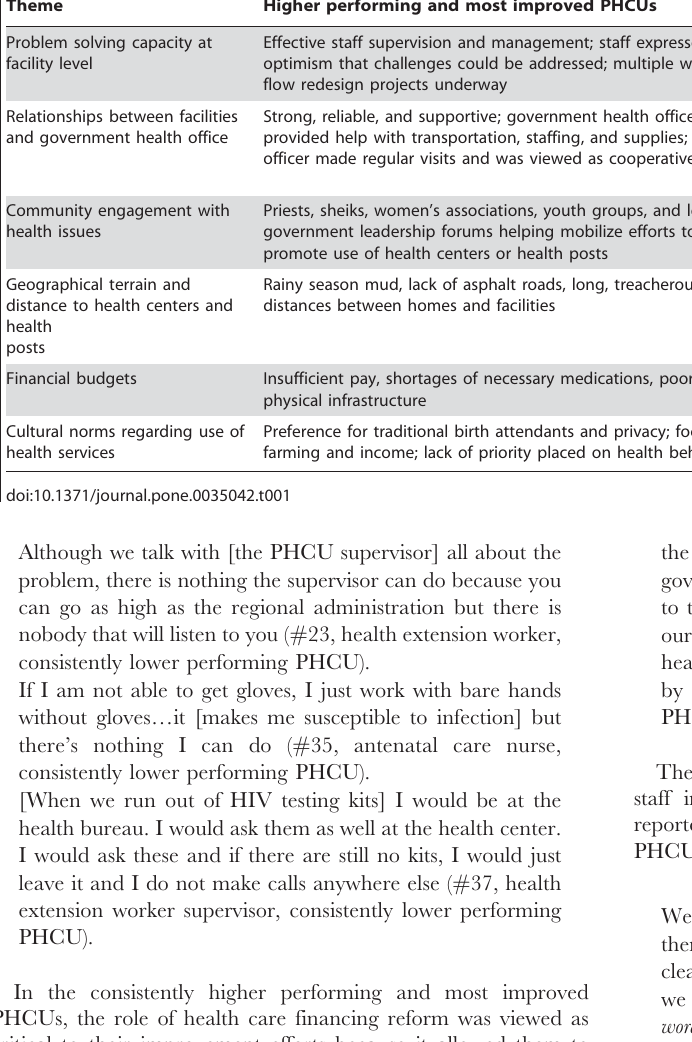
Table 1. Summary of Key Themes.